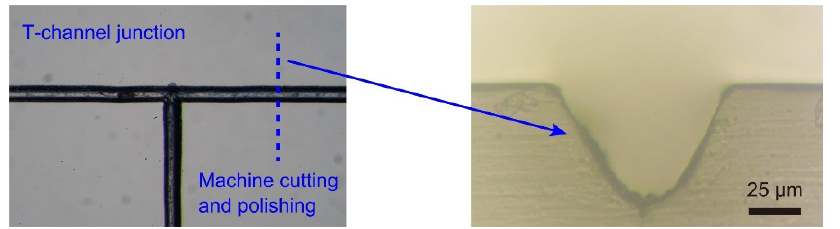
Figure 2. Microscopic observations of laser-engraved microfluidic channels: ( left ) top view of microchannels in the vicinity of a T-junction; ( right ) cross-sectional view of a microchannel.